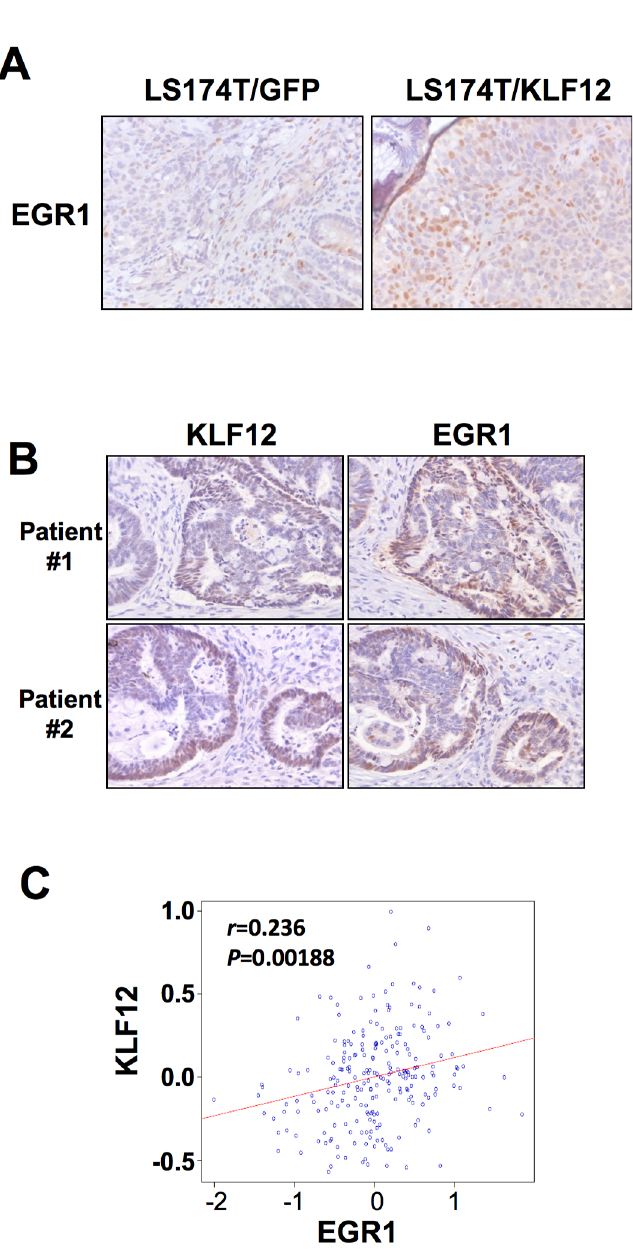
Fig 3. KLF12 and EGR1 is co-expressed in vivo . (A) Immunohistochemistry of EGR1 in nude mice injected with either LS174/GFP cells as control, or with LS174 cells stably transfected with KLF12 (LS174/KLF12). (B) Immunohistochemistry of KLF12 and EGR1 in matching sections taken from two CRC patients (Patient #1 and #2). Magnification x10. (C) Pearson correlation of KLF12 and EGR1 mRNA expression in a cohort of 232 CRC patients (Moffitt cohort, n = 177 and Vanderbilt Medical Center cohort, n =